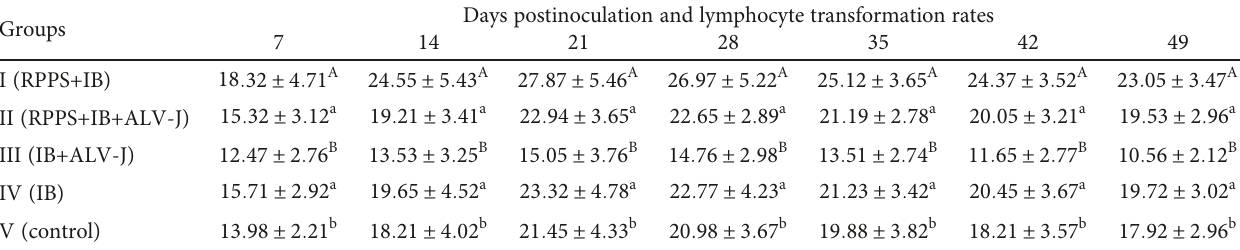
Note: groups with di ff erent superscript lowercase letters are statistically di ff erent at P < 0 05 ; groups with superscript capital letters are statistically extremely di ff erent ( P < 0 01 ). Table 2: E ff ects of RPPS on CD8 + T lymphocyte in the peripheral blood.